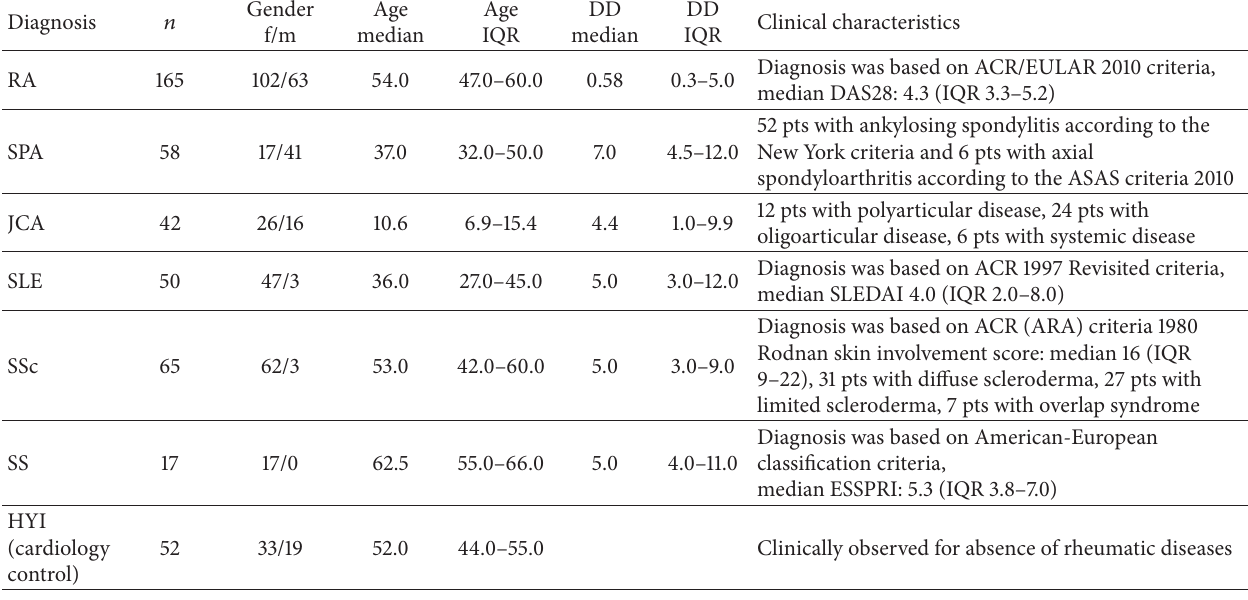
Table 1: Characteristics of individuals studied including 397 patients with systemic autoimmune rheumatic diseases and 174 controls.